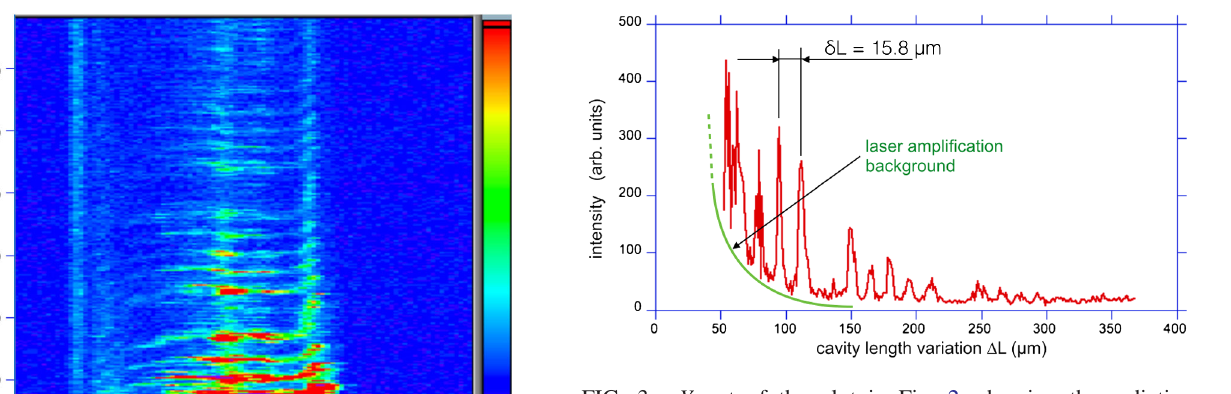
FIG. 3. Y cut of the plot in Fig. 2, showing the radiation intensity vs cavity length variation.